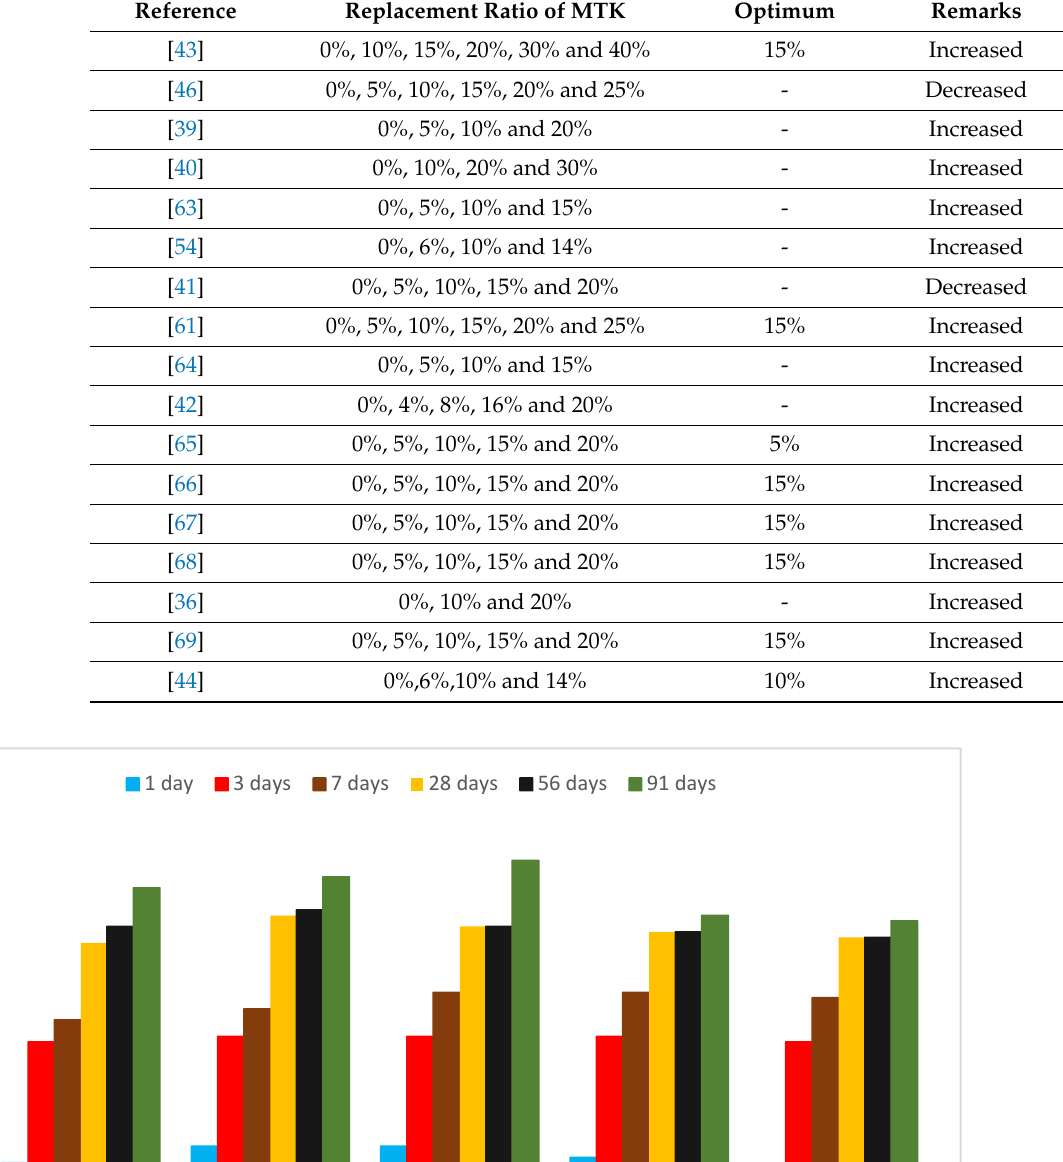
Table 3. A summary of the compressive strength (CS) of concrete.